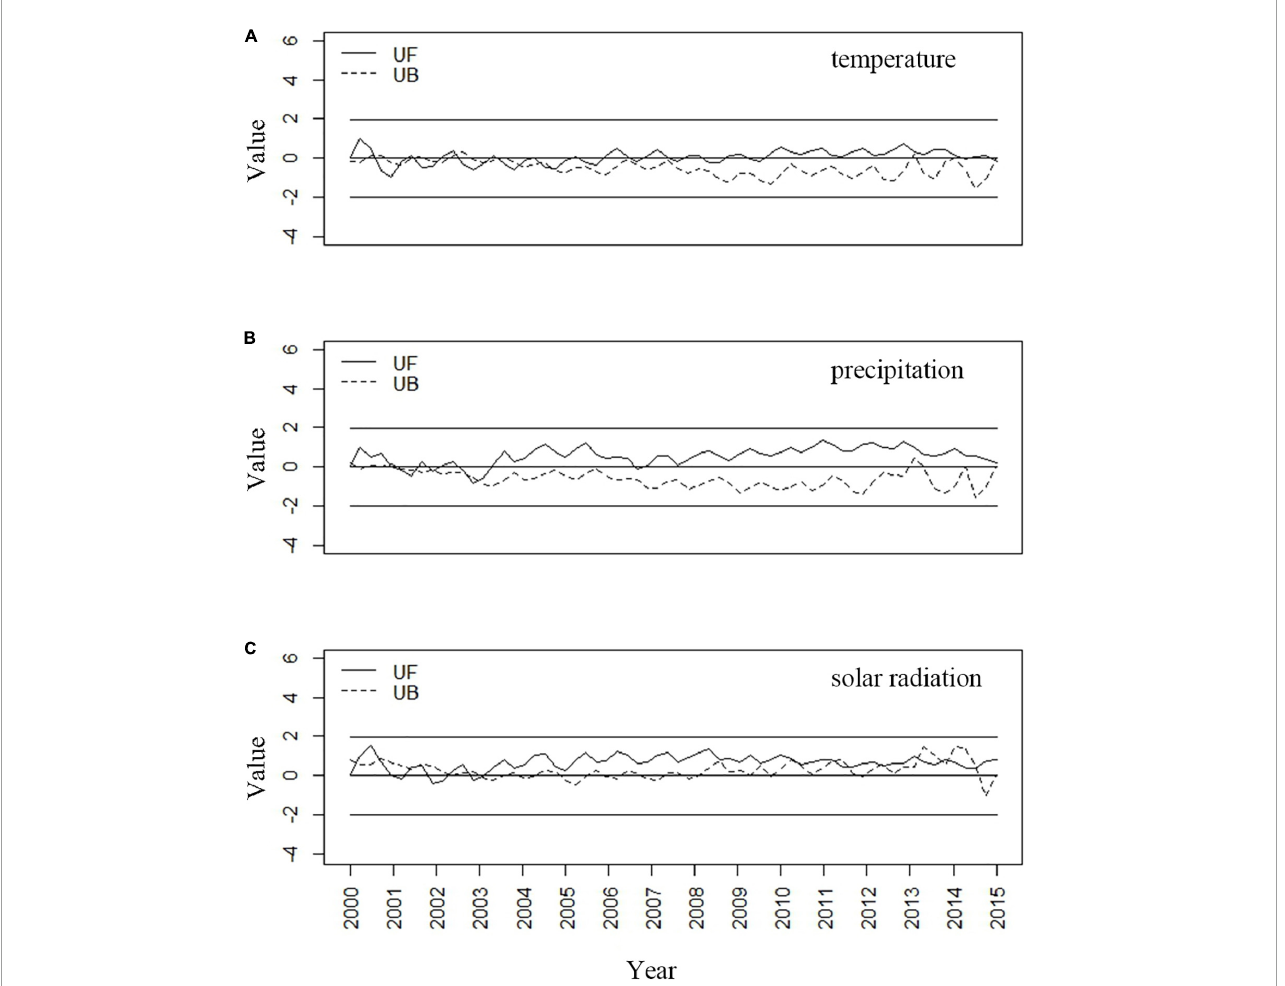
FIGURE8 Mann–Kendall statistic curve of climate in vegetation growing season: (A) temperature (the current month); (B) precipitation (the month before); (C) solar radiation (the 3 months